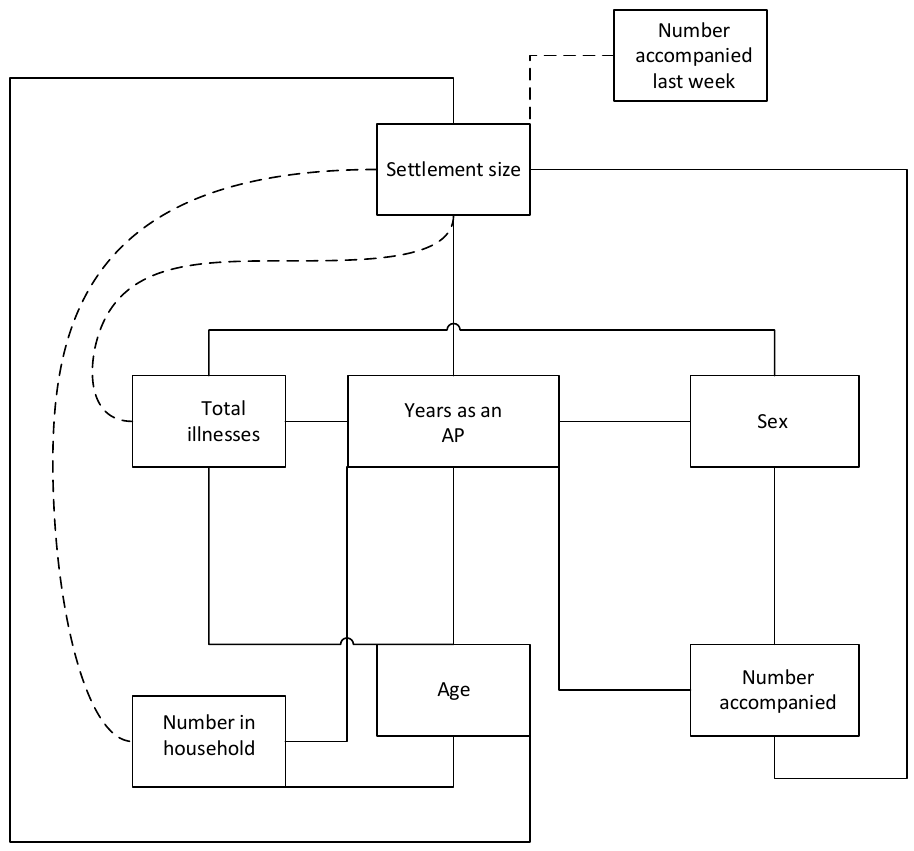
Figure 1. Relationship between statistically-significant variables.